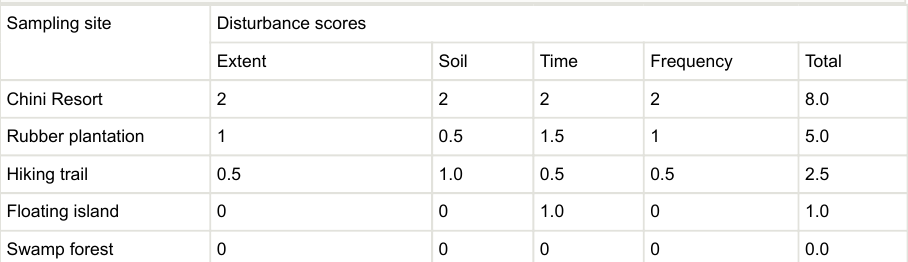
Disturbance scoring is based on Kimberling et al. (2001) scale. Chini Resort scores the highest in anthropogenic disturbance, whereas a site in the alluvial riparian swamp forest has no anthropogenic presence, hence scoring lowest on the disturbance